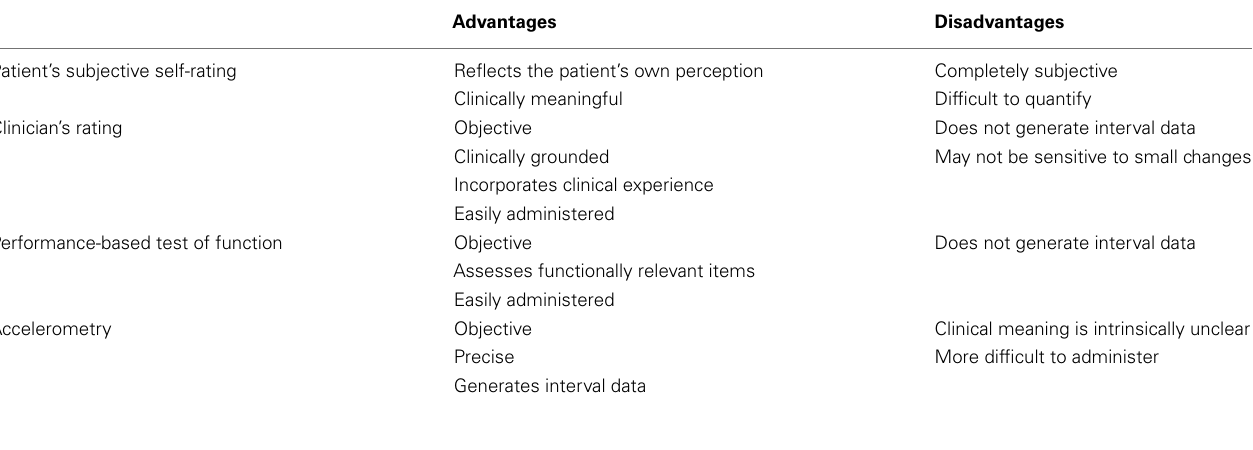
Table 3 |Treatment efficacy endpoints in